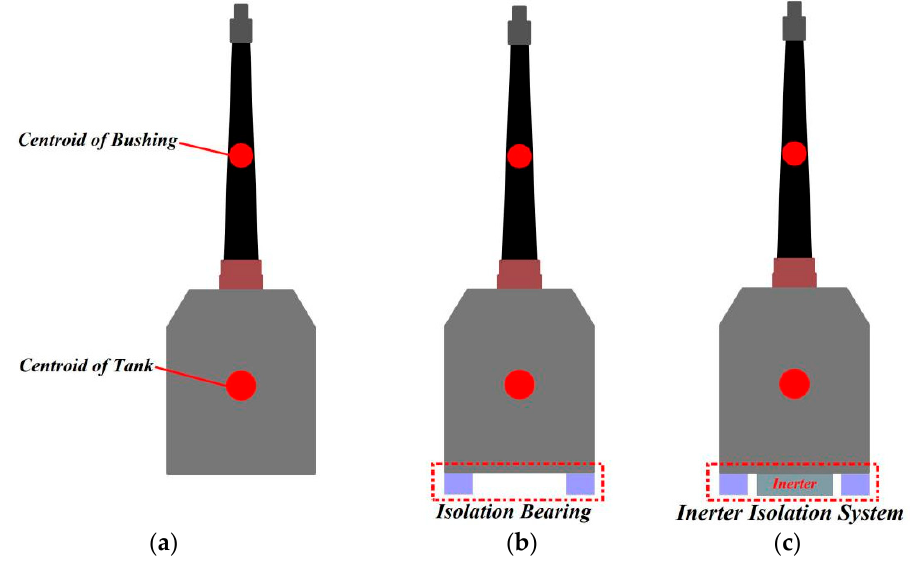
Figure 2. Transformer–bushing system and isolation layer: ( a ) original; ( b ) IB; ( c ) IIS.